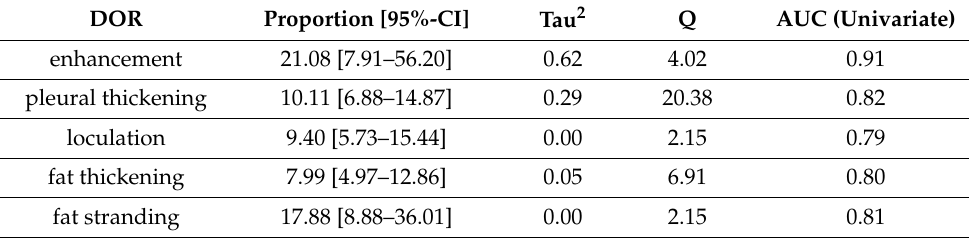
Table A4. DOR independent of negative